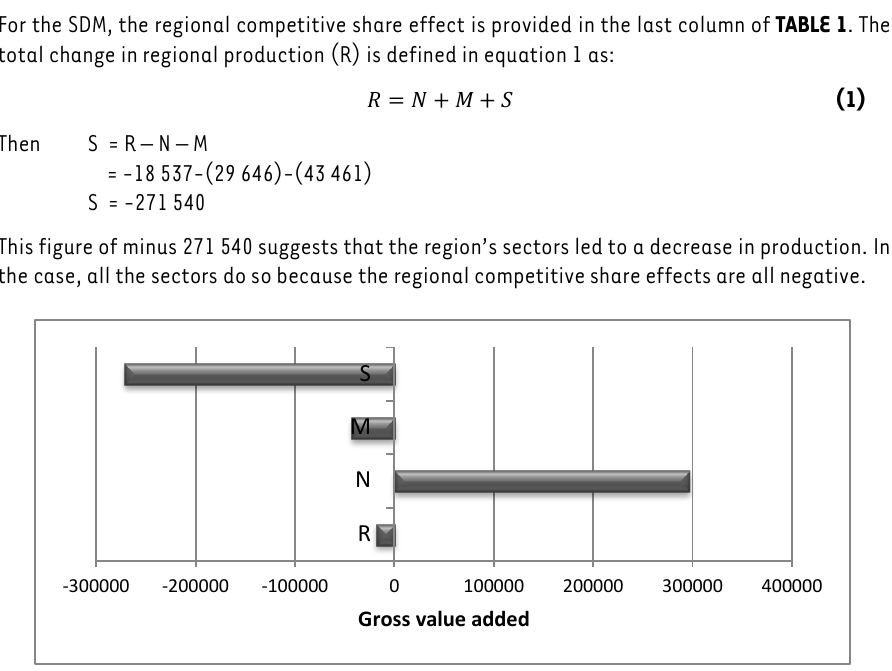
FIGURE 1: Shift-Share Analysis of the Gross Value Added, SDM Source: Authors’